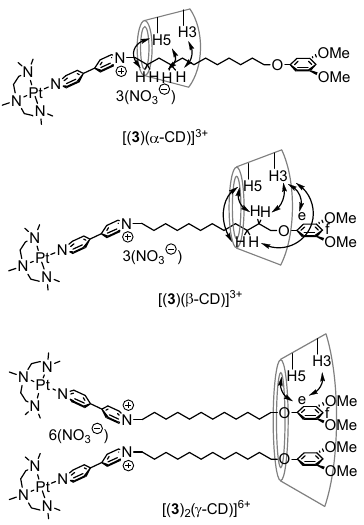
Figure 6. Conformation of polyrotaxanes based on ROESY NMR spectra measurement. Symbols e and f are due to the aromatic hydrogens at the positions. They correspond to the structures in Scheme 2.